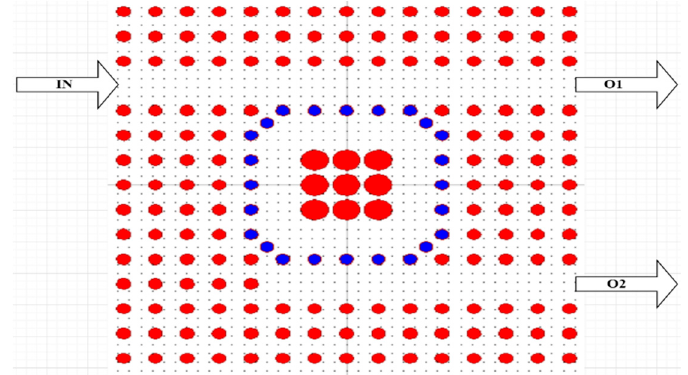
Figure 2. The proposed all-optical switch.